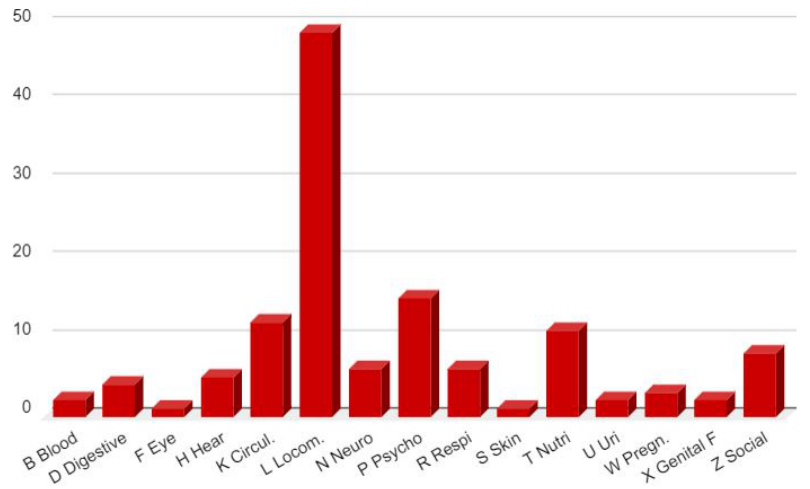
Figure 1. Number of health problems or diagnosis found in the diagnostic index of the first 34 patients at the time of diagnosis of PACS, coded in ICPC-2 chapters (excluding PACS related symptoms and